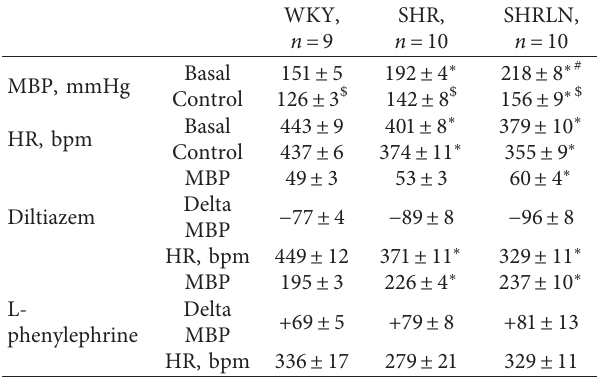
Table 1: Basal and baroreflex data.